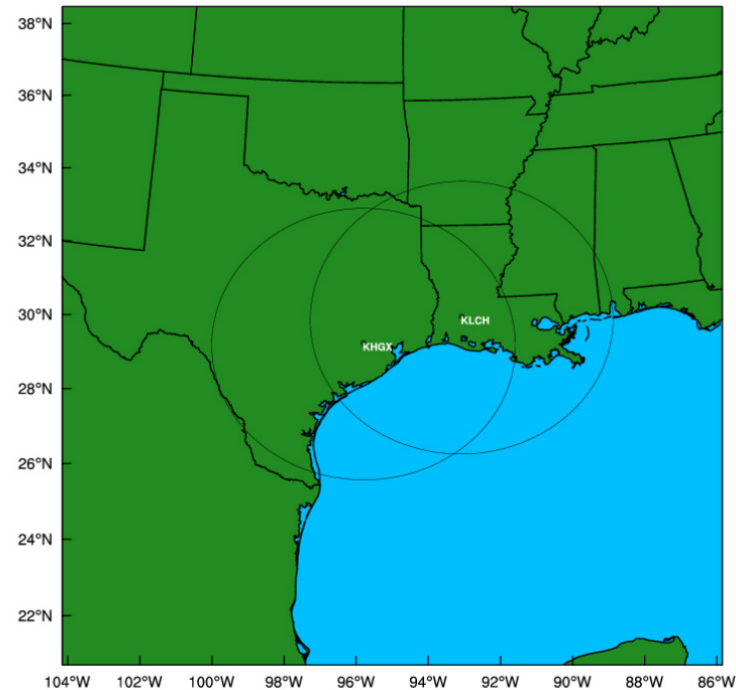
Figure 2. The WRF simulation domain overlapped with the Houston, Texas (KHGX), and Lake Charles, Louisiana (KLCH), Weather Surveillance Radar 88 Doppler (WSR-88D) locations.